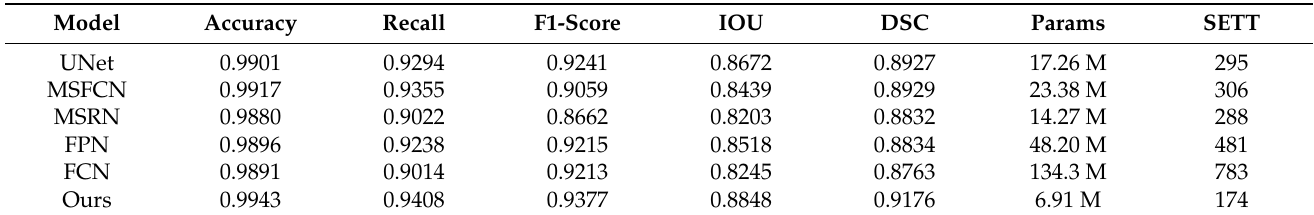
Table 3. Index comparison of different models in different image segmentation